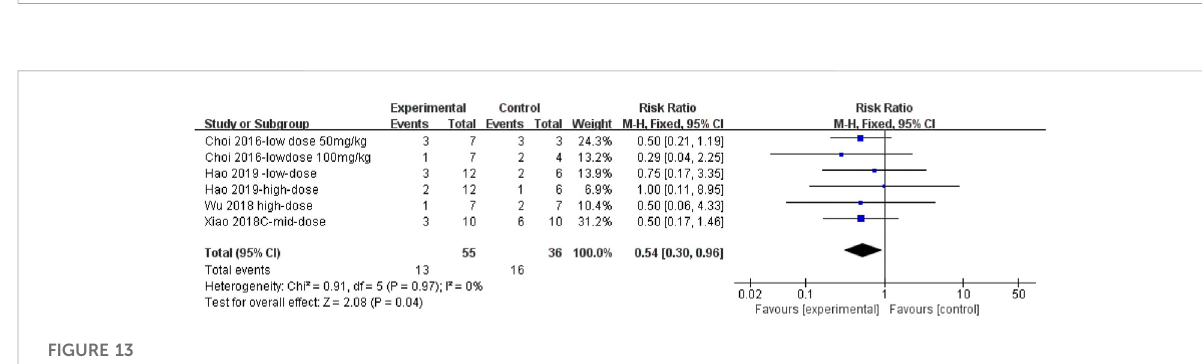
FIGURE 13 Effect of MET on mortality in